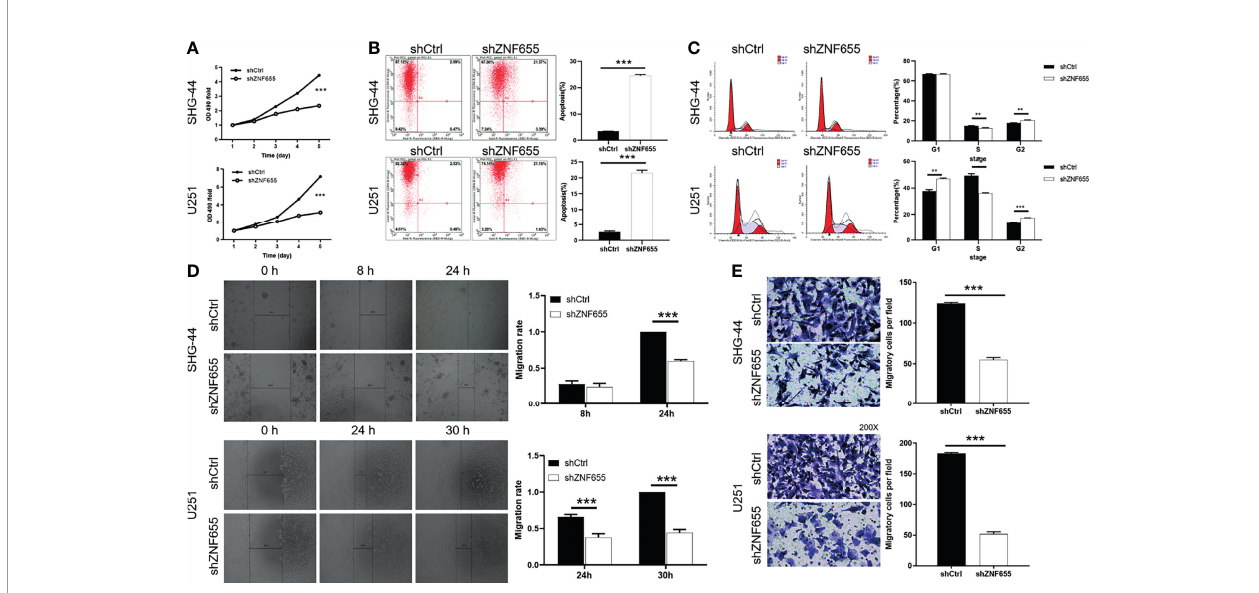
FIGURE 2 | The regulation effects of ZNF655 on cell proliferation, apoptosis, and migration in glioma cells. (A) MTT assay was performed to detect the cell proliferation rate of SHG-44 and U251 cells infected with shCtrl or shZNF655. (B, C) Flow cytometry analysis was performed to show the apoptotic cell percentage (B) and cycle distribution (C) in SHG-44 and U251 cells with or without ZNF655 knockdown. (D, E) Wound-healing assay (D) and Transwell assay (E) were performed to compare the cell migration ability of SHG-44 and U251 cells treated with shCtrl or shZNF655. The data were expressed as mean ± SD (n ≥ 3), **p < 0.01, ***p <